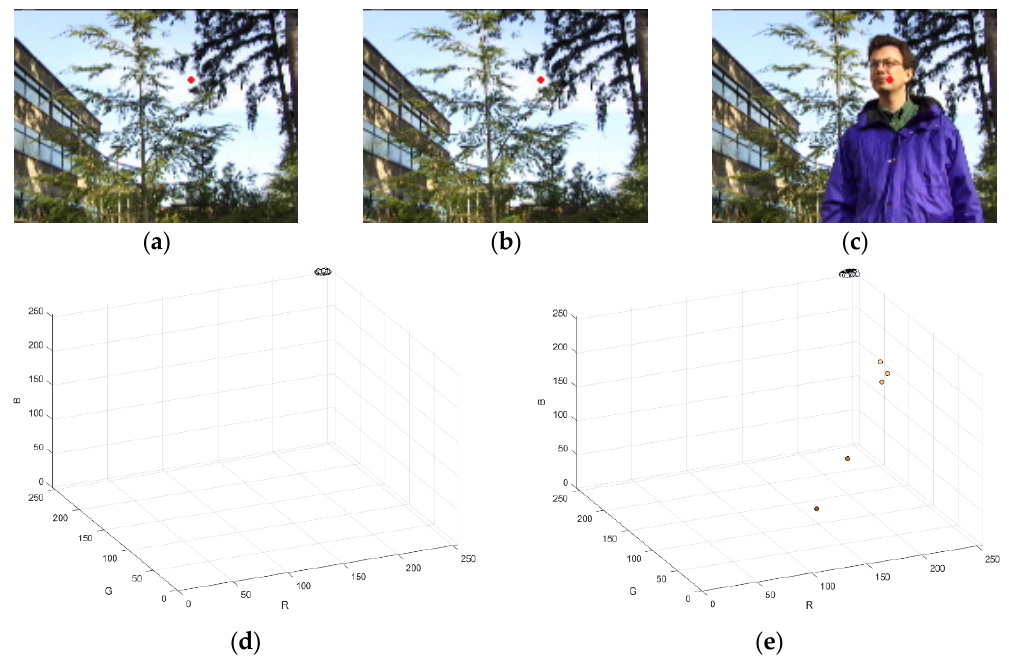
Figure 3. The color change of a video series at the sampling position (100, 40): ( a ) the first input image, ( b ) the 100th input image, ( c ) the 250th input image, with the red dot on the diagram representing the sampling position, ( d ) color distribution of the first to 100th input images, and ( e ) color distribution of the first to 250th input images. Table 1. Color classification results of the first 250 input images at the coordinate (100, 40). Image Interval